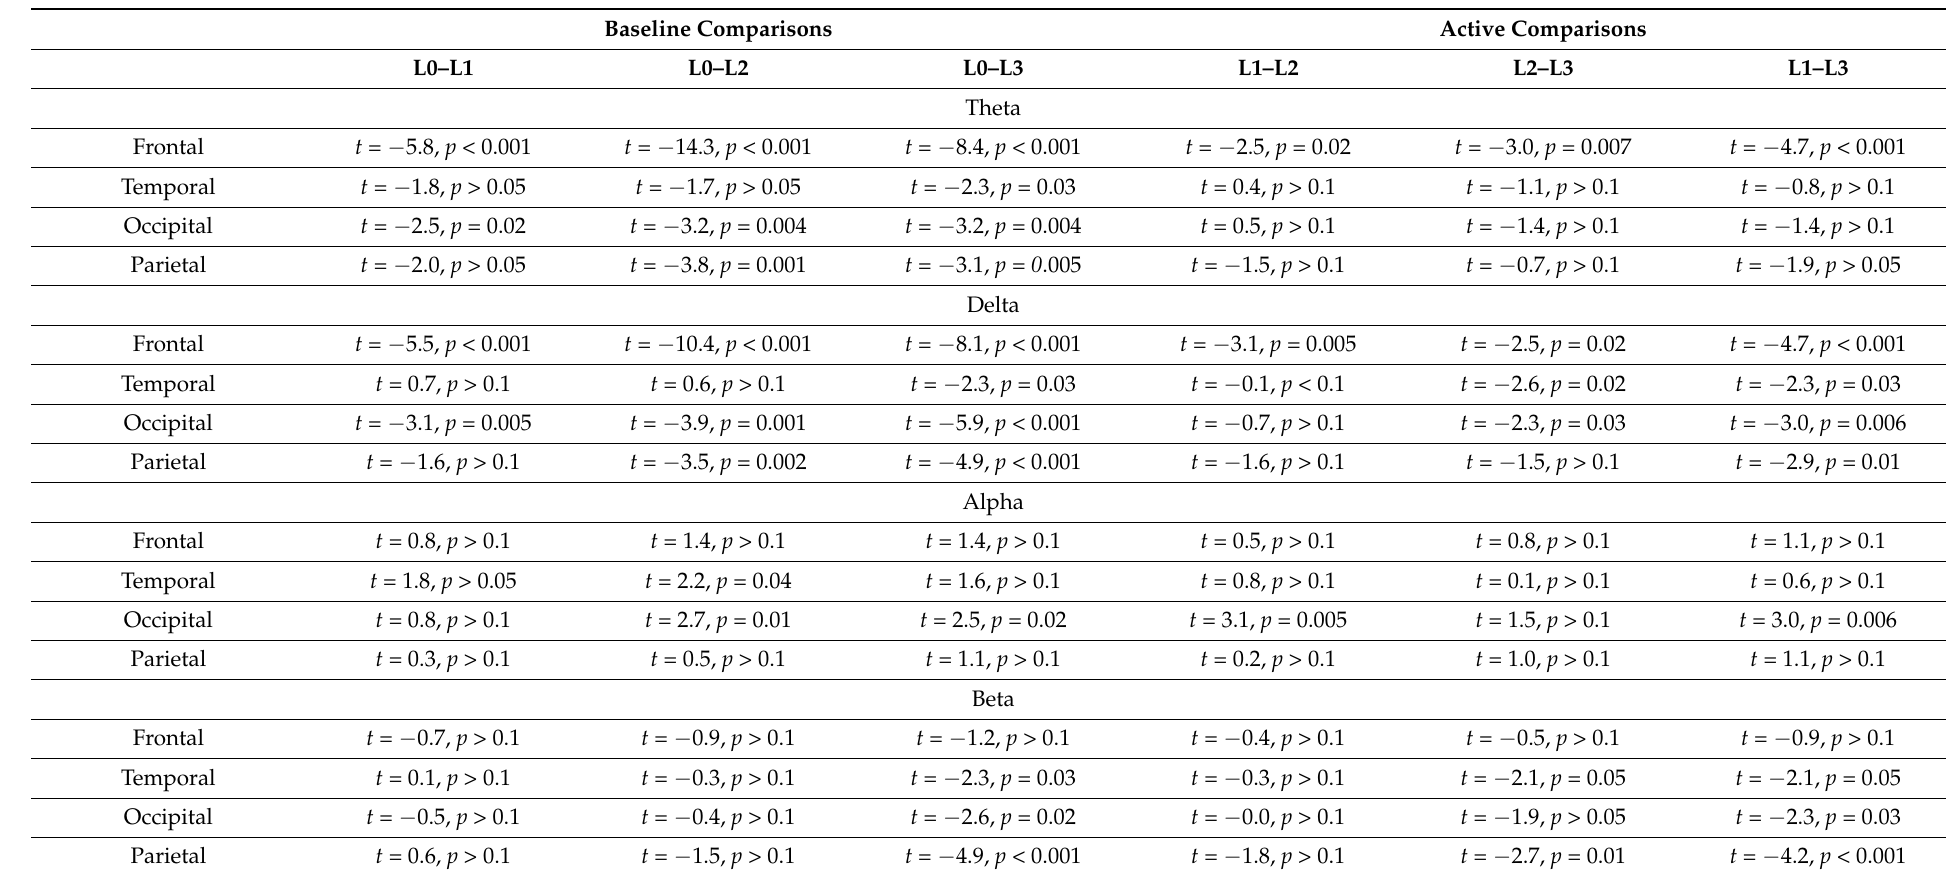
Table A1. Statistics on power measures in the frequency